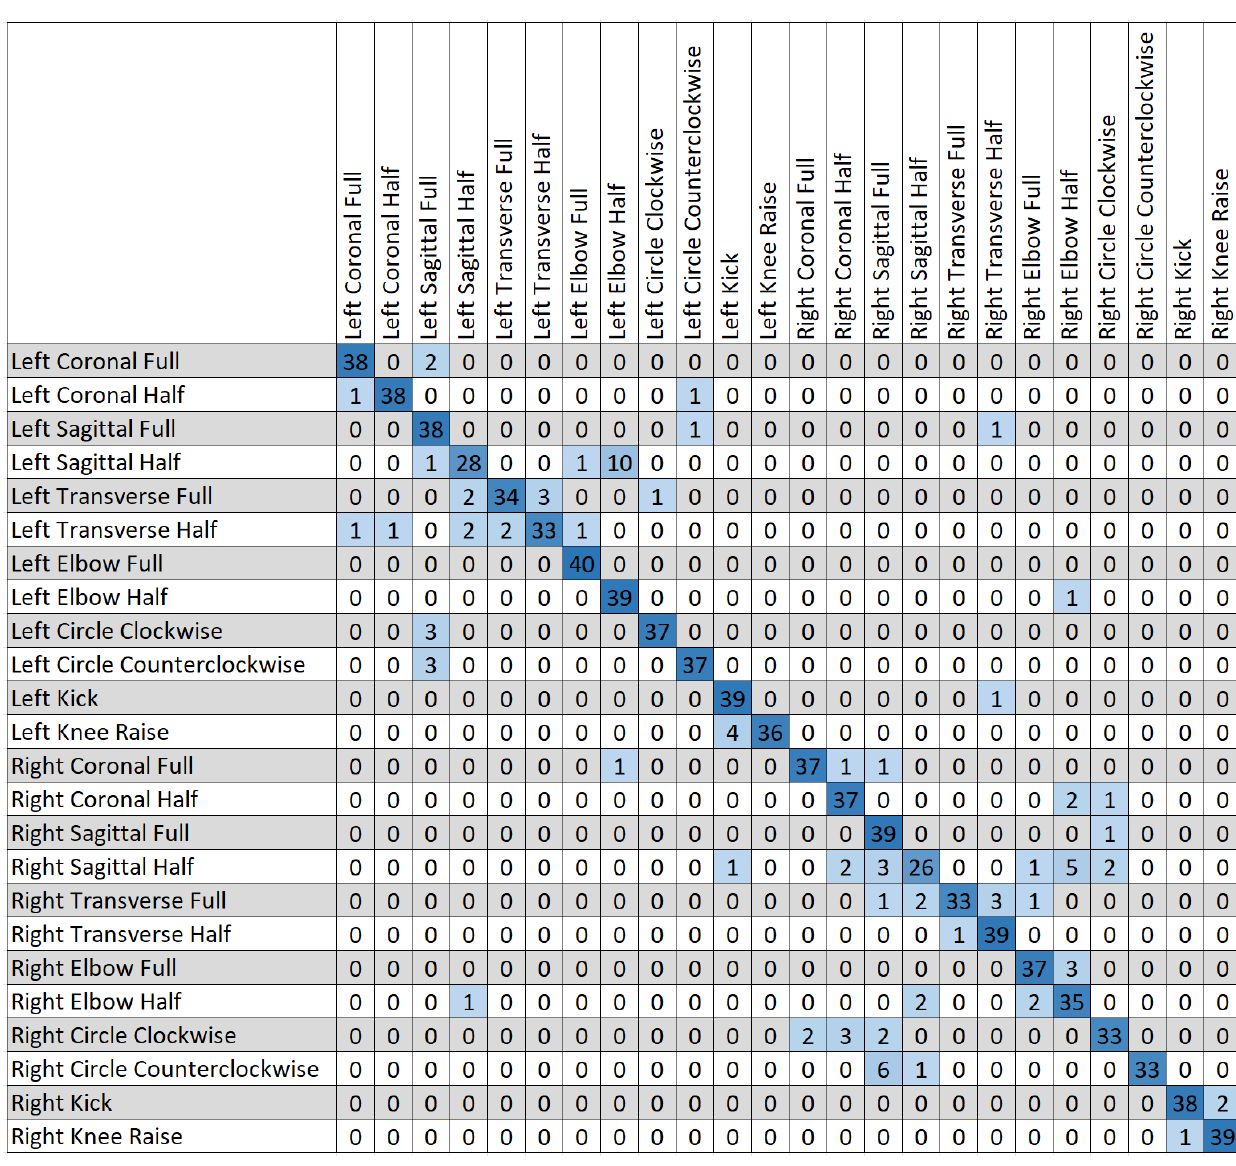
Table 1. Confusion matrix of the test